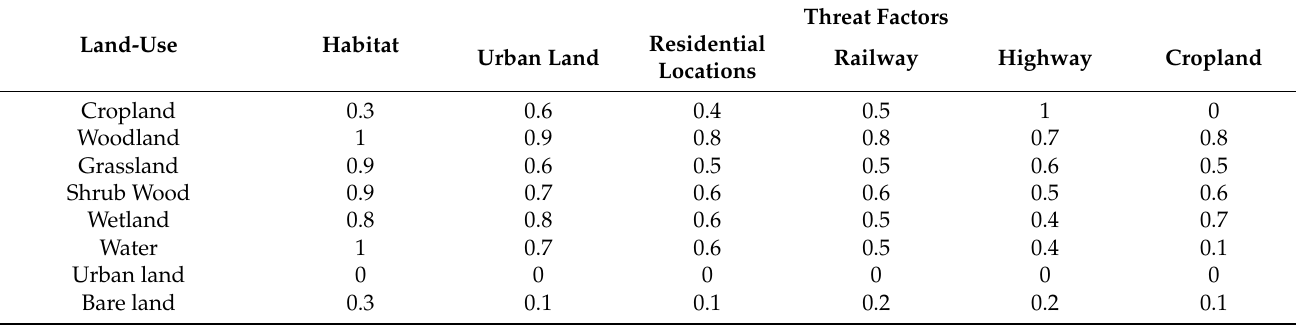
Table 3. Sensitivity of different habitat types to different threat